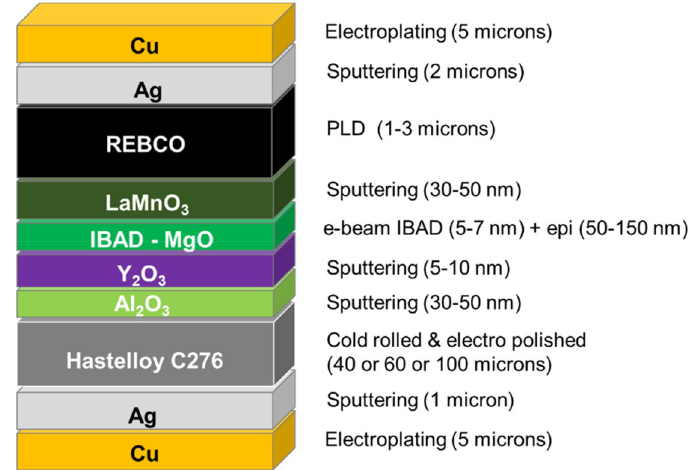
Figure 6. Layer-by-layer structure of 2G HTS wire described in this article.